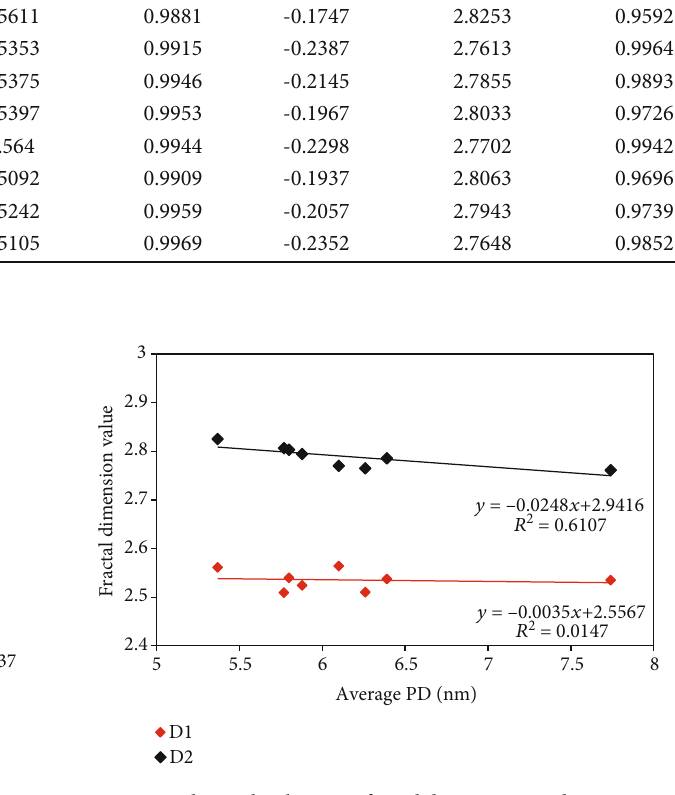
Figure 9: Relationship between fractal dimensions and average PD.